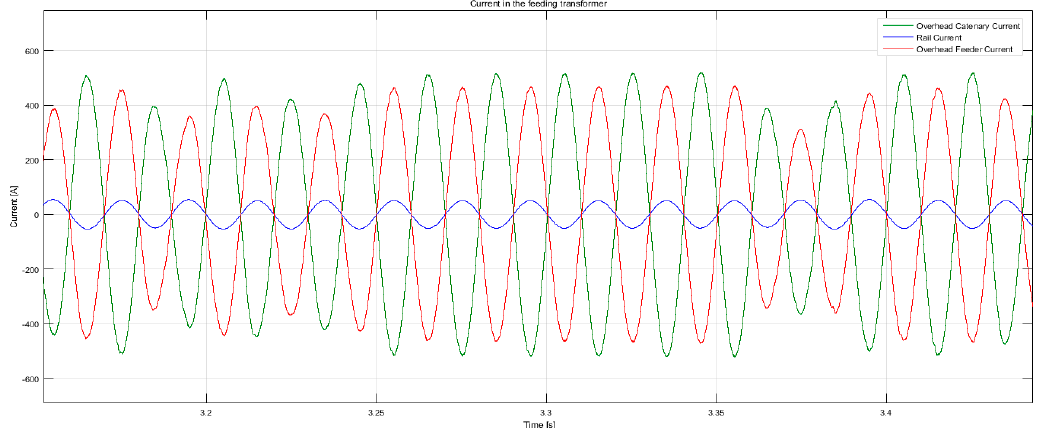
Figure 18. Current measured on the feeding transformer low voltage winding with the charging stations and a train on the tracks.